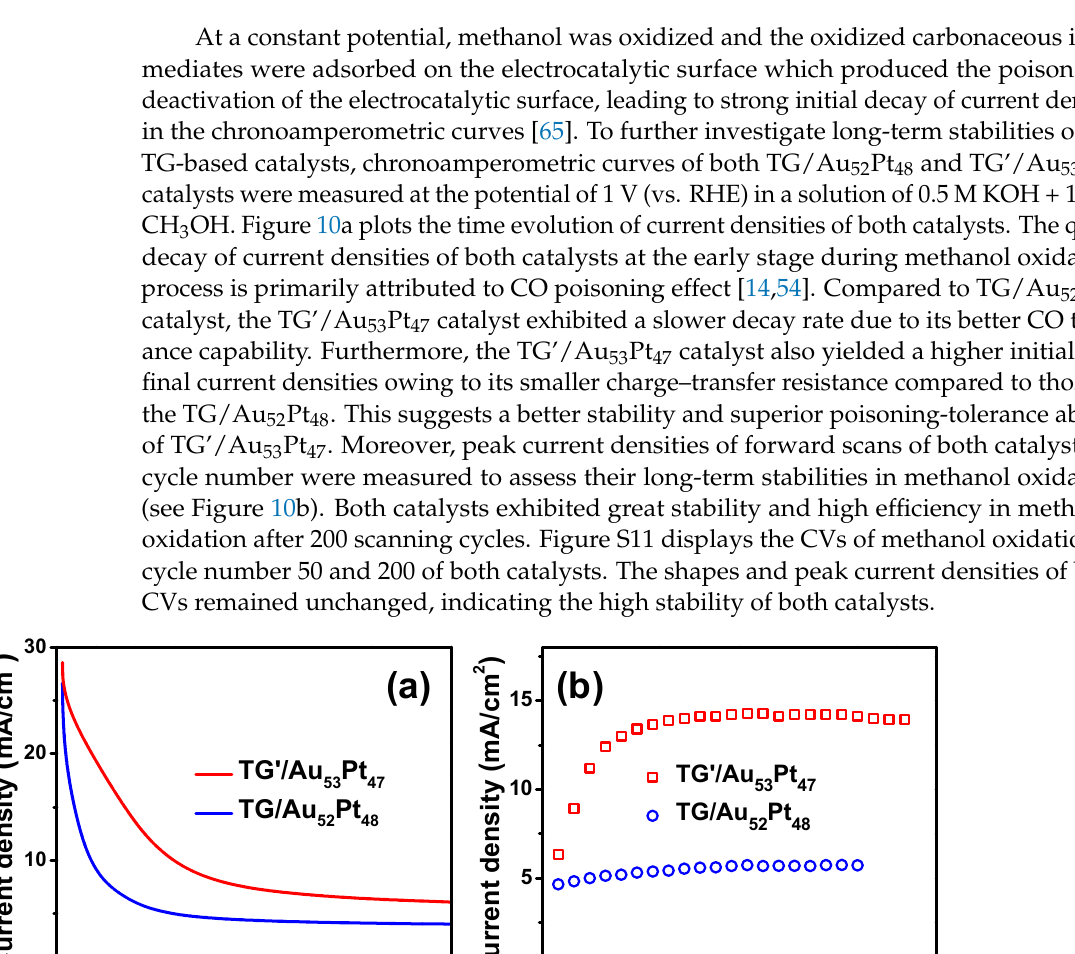
Figure 9. ( a ) The normalized mass activities of TG-based catalysts; ( b ) Nyquist plots of the catalysts of TG (TG’)/Au x Pt y catalysts.